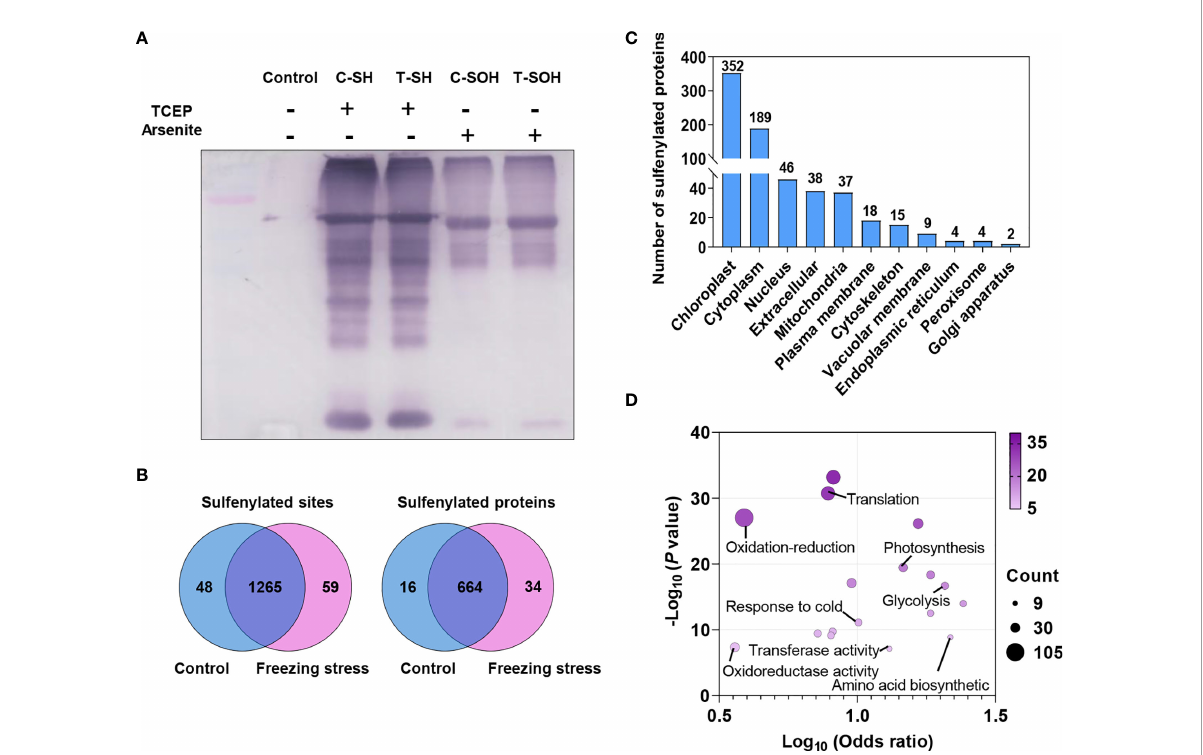
FIGURE 2 Sulfenylated sites and proteins identi fi ed by proteomic analysis in B napus . (A) The detection of total proteins reduced by TCEP and arsenite was performed by Western blotting using anti-TMT ™ antibody. Reduced (SH) and sulfenylated (SOH) proteins in control (C) and freezing treatment after cold acclimation (T) samples were labeled, respectively. Proteins without label were used as control. (B) Venn diagram showing the shared sulfenylated sites and proteins identi fi ed in control and stressed samples. The number of sites and proteins are listed in each diagram component, respectively. (C) The distribution of predicted subcellular localizations of sulfenylated proteins. (D) GO enrichment analysis of sulfenylated proteins. The Log 10 (Odds ratio) is plotted on the x-axis. The size and color of dots indicate the number of sulfenylated proteins and the degree of enrichment (-Log 10 ( P value), P < 0.05),